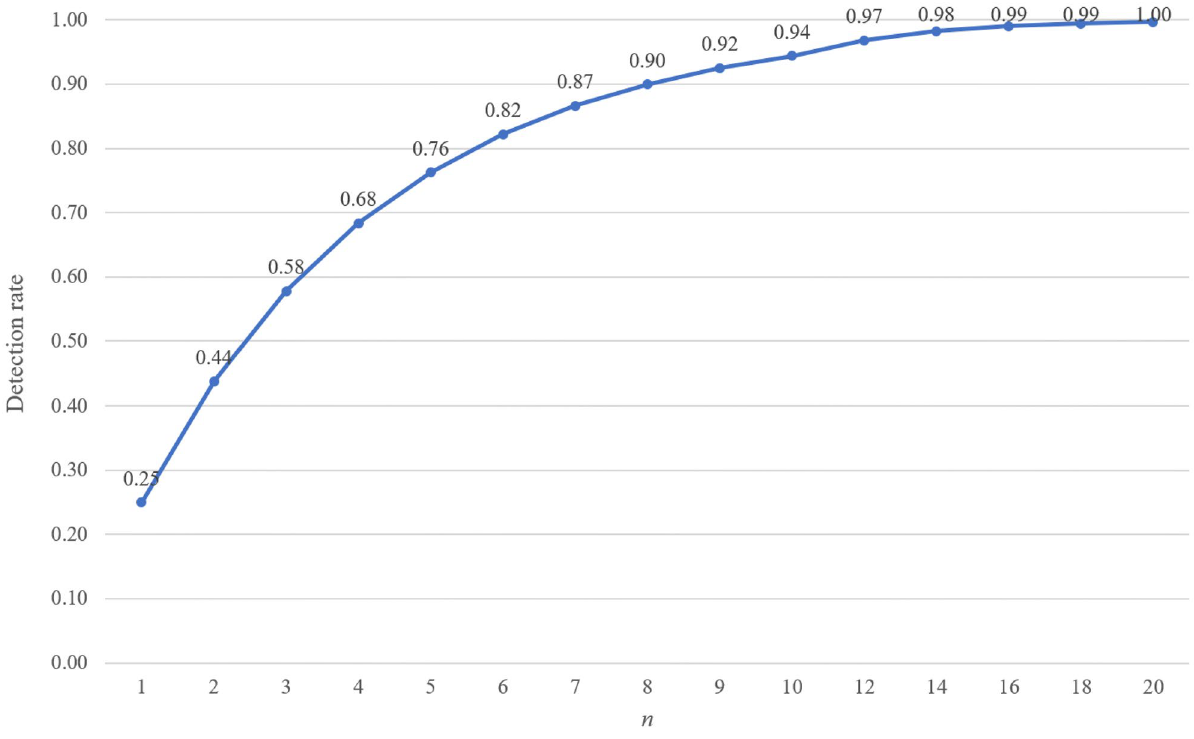
Figure 3. Detection rate of the intercept-resend attack.